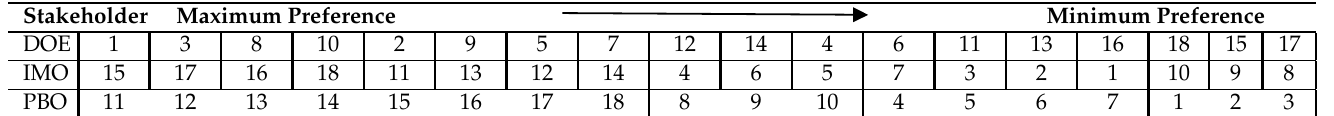
Table 4. Preference rating of possible conflict situations for each stakeholder from maximum to minimum.